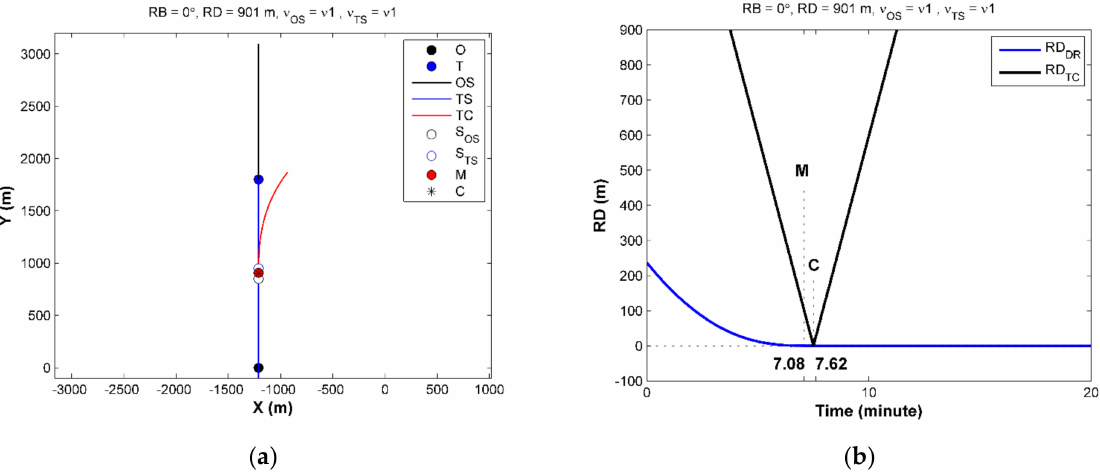
Figure 14. Estimation results for Scenario 1 (1-degree head-on situation): ( a ) OS-TS encounter and collision points; ( b ) Estimation of the OS-TS relative distance and the time at collision Points C and M over time. OS-TS initial relative distance of 901 m, initial speed of both vessels ν 1(5 knots).